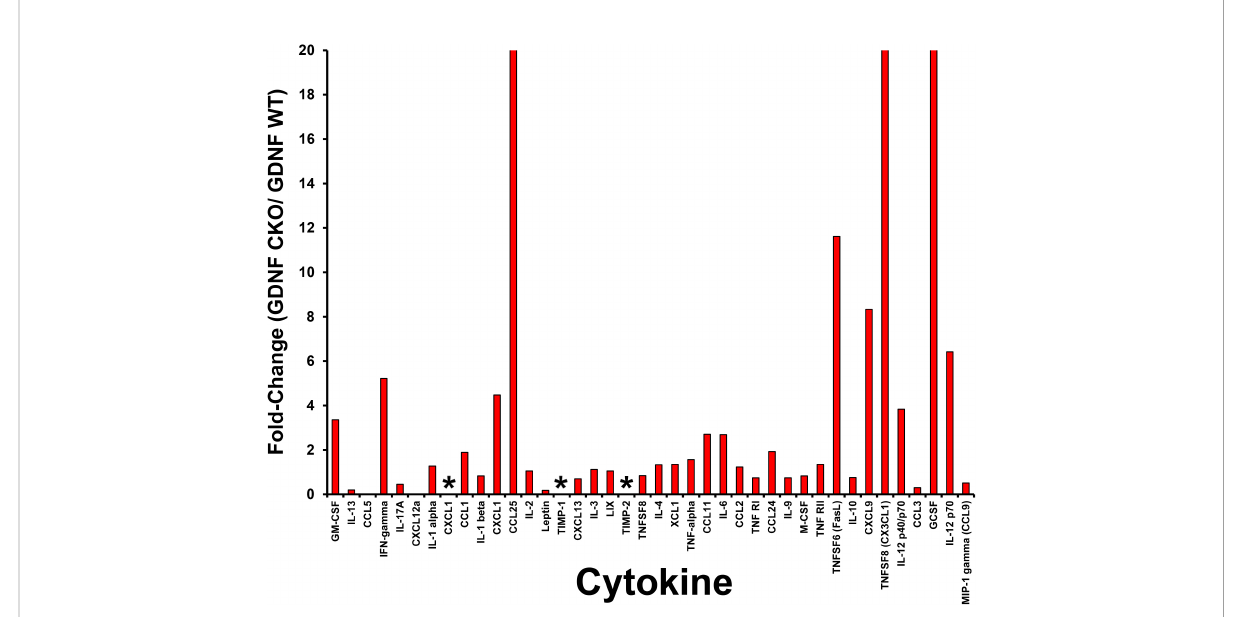
FIGURE 11 Relative sciatic nerve cytokine expression in Gdnf CKO and Gdnf WT mice following unilateral crush injury. Bar histograms from a representative whole sciatic nerve homogenate semi-quantitative cytokine array spot densitometry experiment demonstrating relative normalized cytokine expression in injured sciatic nerves from Gdnf CKO and Gdnf WT mice are shown. High relative cytokine expression in the injured sciatic Gdnf CKO mice compared to Gdnf WT mice may be associated with subsequent development of chronic nociception. The highest relative expression is seen in CXCL1, TIMP-1 and TIMP-2, with >20-fold increases seen in CCL25, CX3CL1 and GCSF. * indicates a ratio of in fi nity. N = 4 (16 sciatic